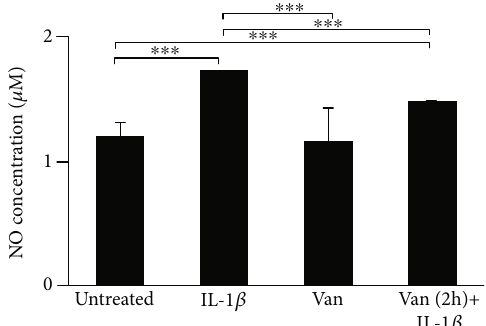
Figure 5: Levels of NO in HGF cells were determined based on Griess reagent reaction. Experiments were conducted in duplicate, and changes were reported as mean ± SD ; ∗∗∗ p < 0 : 001 . IL-1 β : IL- 1 β -primed cells; Van: Vanillin; Van (2 h)+IL-1 β : Vanillin (2 h pretreatment) plus IL-1 β